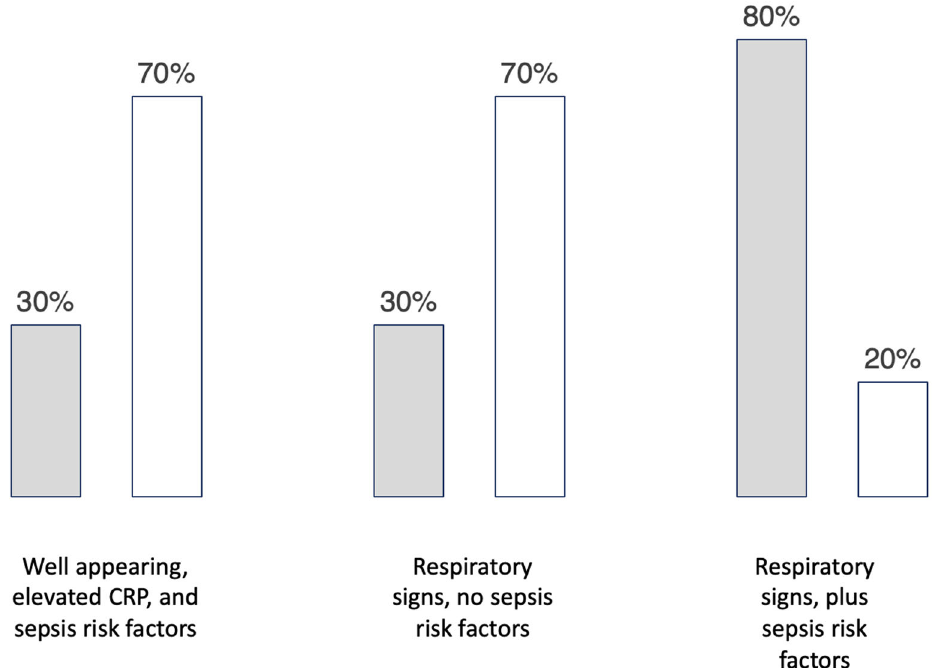
Figure 4. The set of histograms shows the results of a single vignette with three sets of variables added to determine the proportion of prescribers choosing to start antibiotics (grey) and the proportion choosing no antibiotics (white).